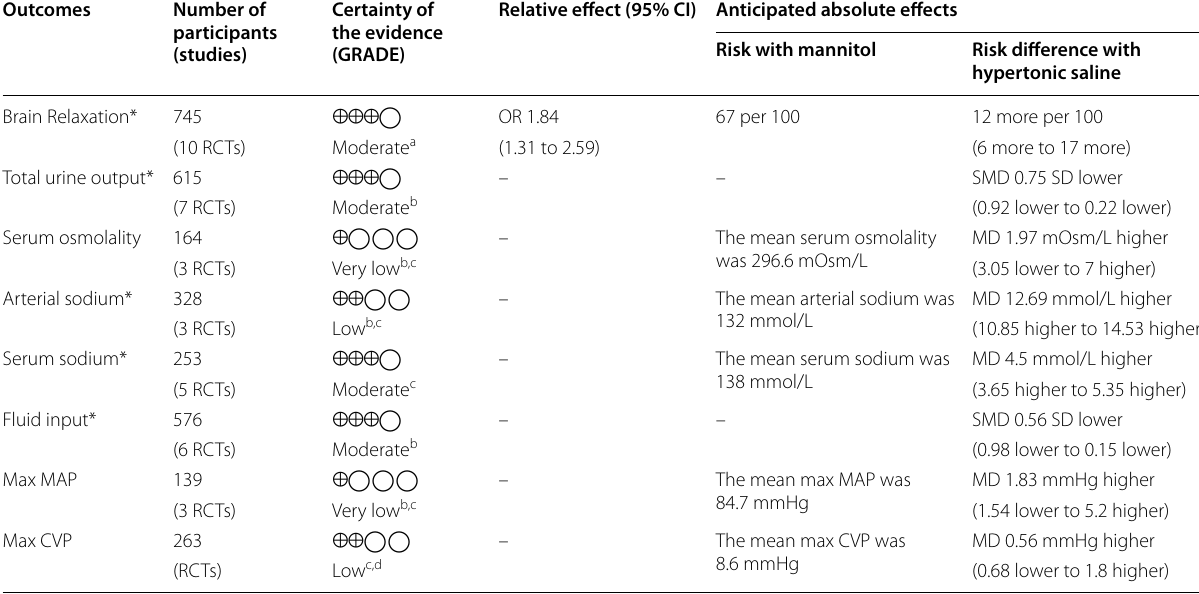
Table 1 Detailed participants for each outcomes including their quality of